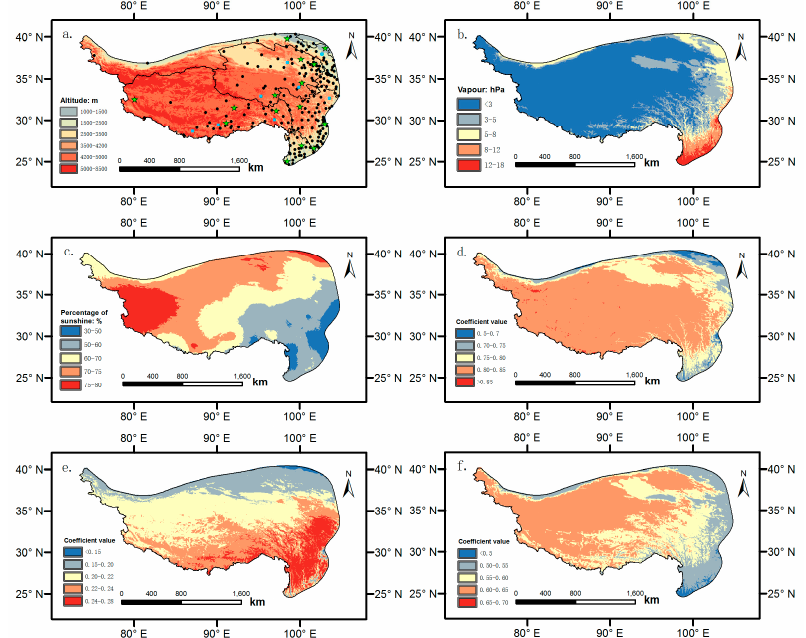
Figure 7. Distribution of weather stations, the interpolated meteorological variables and the rasterized coefficients of the Ångström model. ( a ) Distribution of weather stations, stars denote radiation stations, dots the weather stations, and squares weather station used for validation of ANUSPLIN method, ( b ) annual mean water vapor pressure (unit: hPa), ( c ) annual mean sunshine percentage, ( d ) coefficient ( a + b ), ( e ) coefficient a , and ( f ) coefficient b .